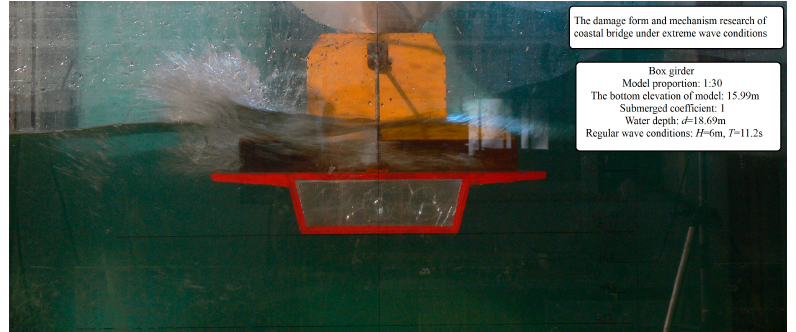
Figure 2. Experiment setups for numerical model validation.